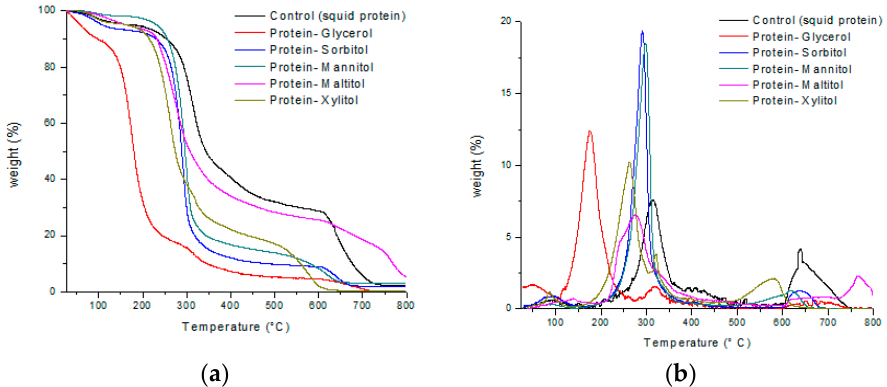
Figure 4. ( a ) TGA thermograms (TG) and ( b ) temperature derivative (DTG) thermograms of the protein films of jumbo squid ( Dosidicus gigas ) with different plasticizers.